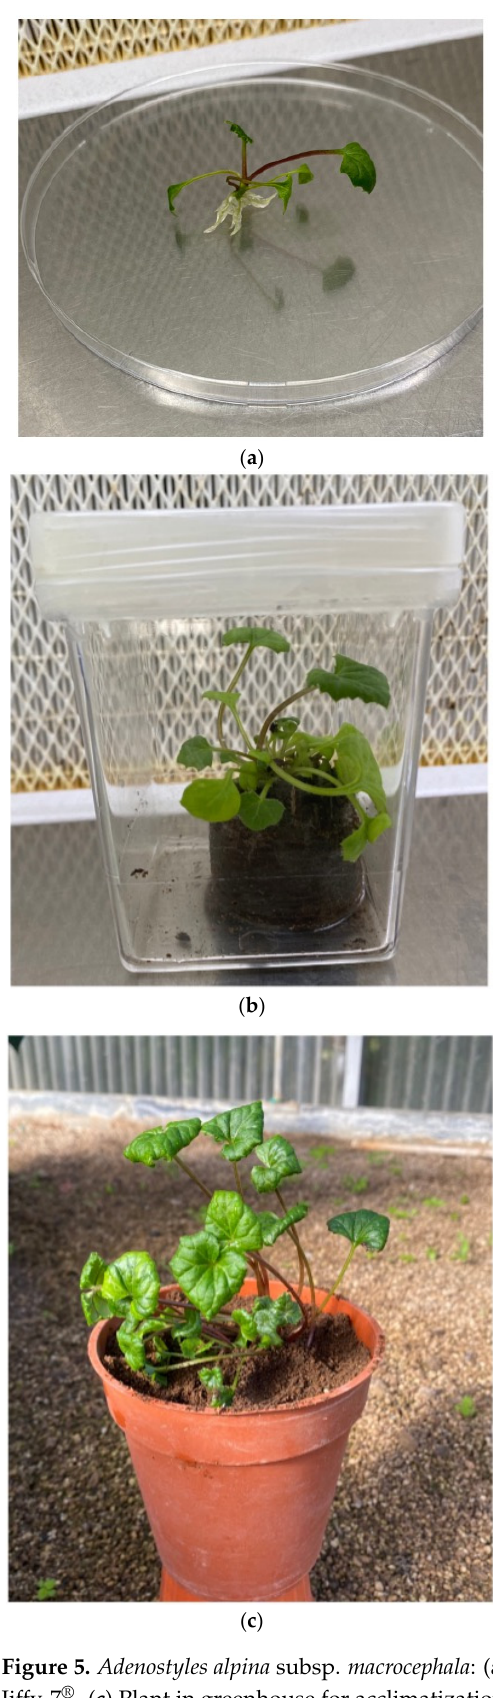
Figure 5. Adenostyles alpina subsp. macrocephala : ( a ) In vitro rooting of shoots. ( b ) Plantlet placed in Ji ff y-7 ® . ( c ) Plant in greenhouse for acclimatization. The percentage of plants acclimatized to greenhouse conditions was 70%. The individuals produced have a number of leaves between 10 and 15, with an average height of 20 cm. The health status is overall good. Despite the non-optimal transplant period and environmental conditions, the satisfactory results obtained can be a tt ributed to the good quality of the roots produced. Plants moved outdoors, on hills, and entered vegetative rest after two weeks, which is in accordance with the taxon’s vegetative cycle. This outdoor parcel will be used in the next few years to monitor the acclimatization in natural conditions of these individuals obtained in vitro. 3. Materials and Methods 3.1. Plant Material and Culture Media 3.1.1. Collection and Sterilization of Plant Material We opted to use small leaf portions as propagation material due to their ease of harvesting and minimal harm to the plants when cut. The apical/nodal explants are not to be taken from rhizomes that are underground. Young leaves with an area of about 10 cm 2 of Adenostyles alpina subsp. macrocephala were collected from di ff erent individuals randomly selected within the population growing along the Torrente Telese, Gambarie (South Italy, Calabria), 1420 m a.s.l., 38.175053° N, 15.856755° E (WGS84), on 16 June 2022, by G. Domina, E. Di Gristina, and G. Barone (voucher specimen housed in the SAF herbarium of the Department of Agriculture, Food, and Forest Sciences of the University of Palermo). The leaves were transported to the laboratory in plastic bags stored at about 7 °C and processed within 12 h of collection. The process of sterilizing plant material (explants) is an important activity in tissue culture which aims to eliminate microorganisms carried during explant extraction, which can cause contamination. The leaves were disinfected by standard methods using ethanol/sodium hypochloride [70]. The explants were sterilized by immersion in a 70% ethanol solution for 5 min and then